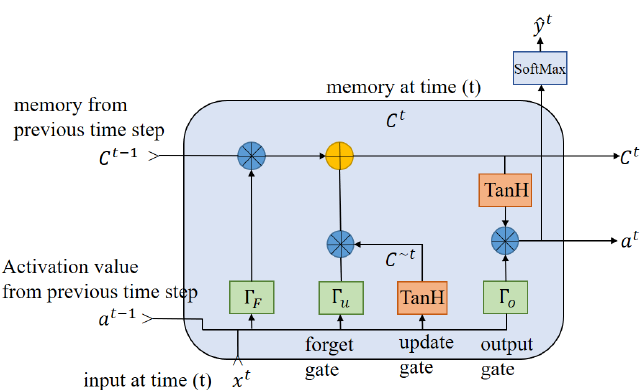
Figure 15. Internal structure of the LSTM model.